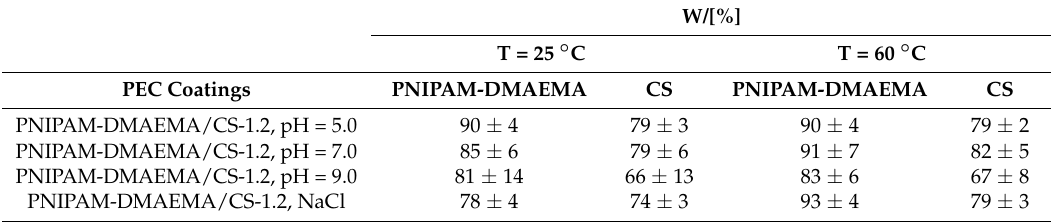
Table 4. Wet-adhesiveness W = A AFTER /A BEFORE × 100% of PNIPAM-DMAEMA/CS-1.2 complex coatings for pH = 5.0, 7.0 and 9.0 and 0.1 M NaCl at T = 25 and 60 ◦ C obtained by FTIR spectroscopy. W/[%] T = 25 ◦ C T = 60 ◦ C PEC Coatings PNIPAM-DMAEMA CS PNIPAM-DMAEMA